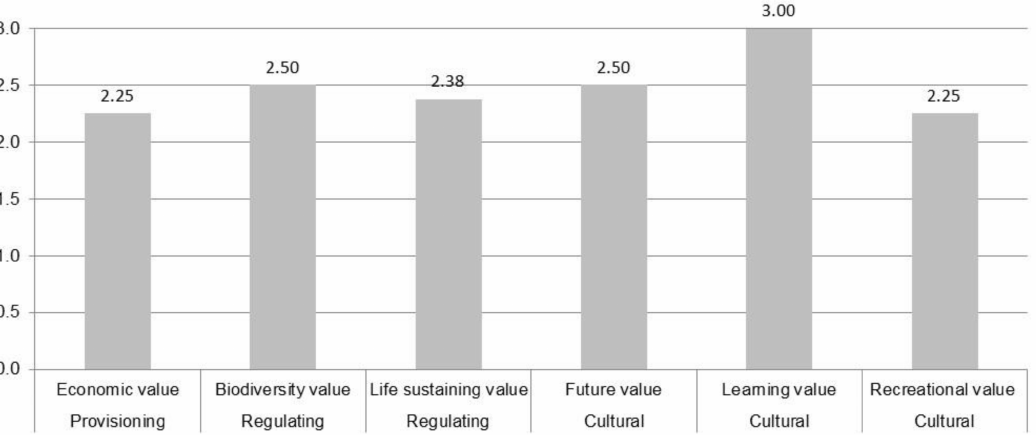
Figure 7. While previously the scores obtained by the most ranked ES per each assessment method were shown, here, the results are combined to allow for a comparison. The values of the six most ranked ES by residents on a Likert scale from 0 to